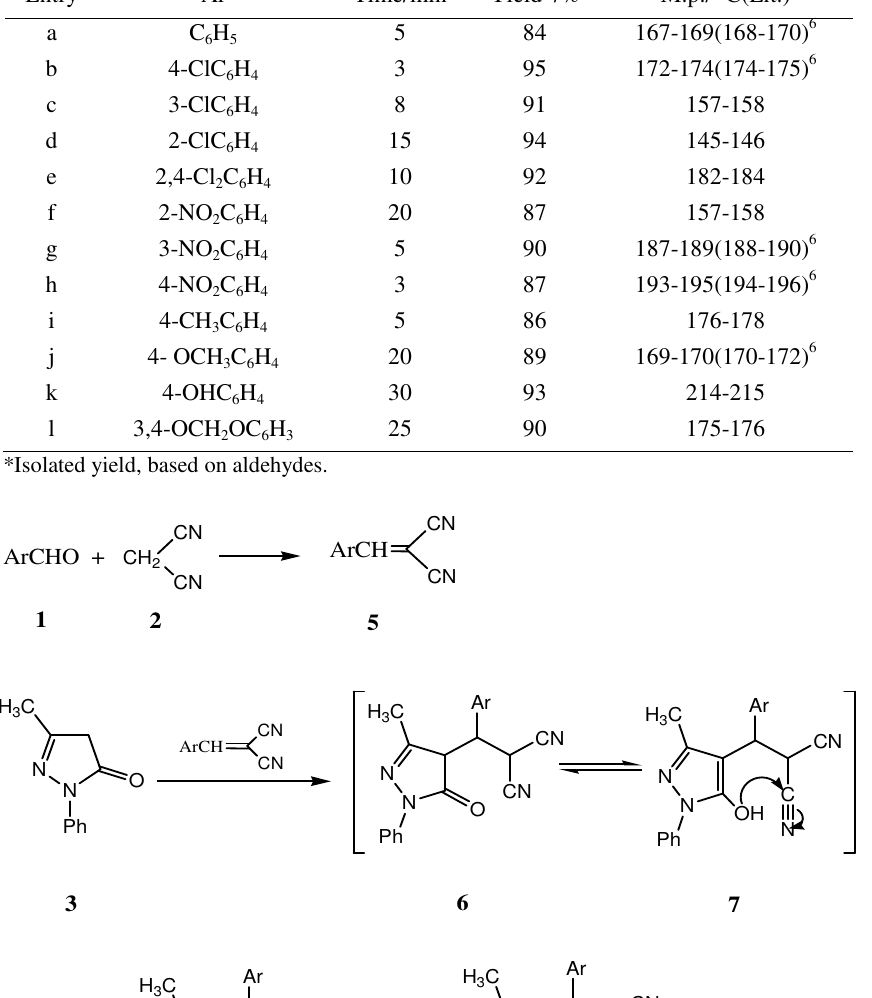
Table 1. Condensation of aromatic aldehydes, malononitrile with 3-methyl-1-phenyl-2- pyrazolin-5-one in EtOH with no catalyst under ultrasound irradiation Time/min Yield*/% M.p./ o